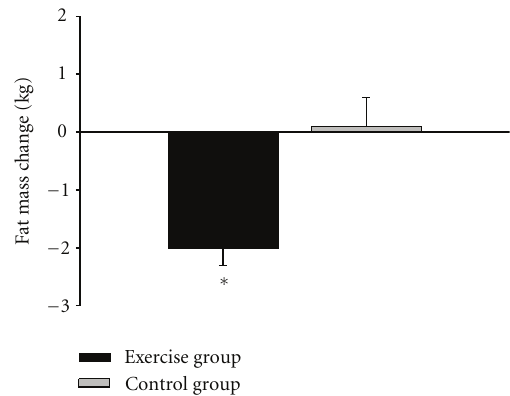
Figure 1: Total fat change for the high-intensity intermittent exercise and no exercise control groups ( N = 38, mean and standard error). ∗ Significantly di ff erent from control group ( P < 0 .